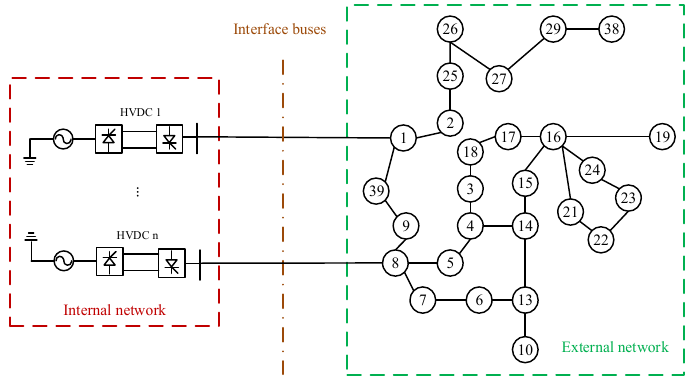
Figure 2. Topology of the power system.